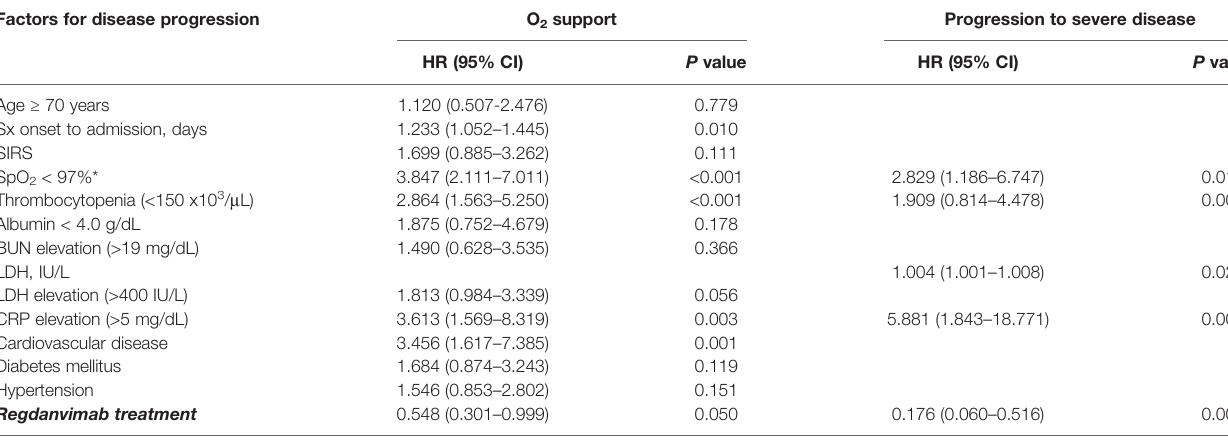
TABLE 4 | Multivariate analysis of 21-day disease progression probability of the PS-matched cohort. Factors for disease